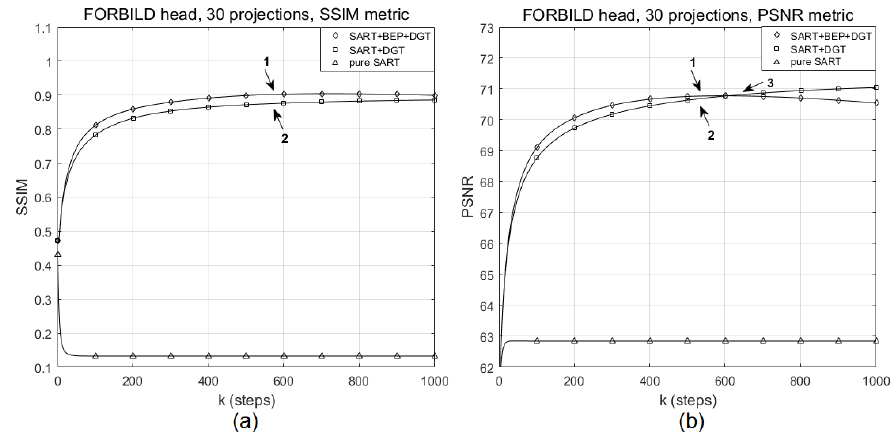
Figure 7. Evolution of ( a ) SSIM and ( b ) PSNR values for a particular reconstruction of the FORBILD head phantom with 30 projections using the pure SART, SART+DGT, and SART+BEP+DGT methods.